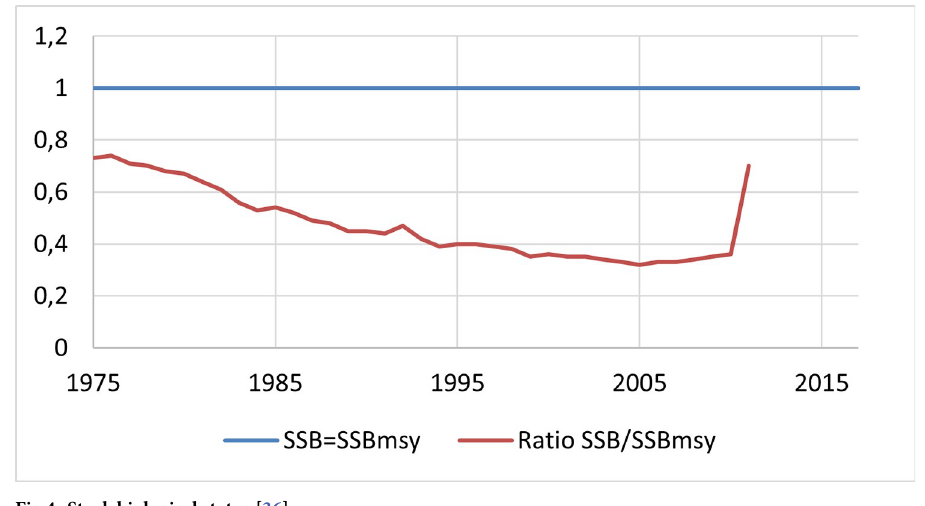
Fig 4. Stock biological status [36].